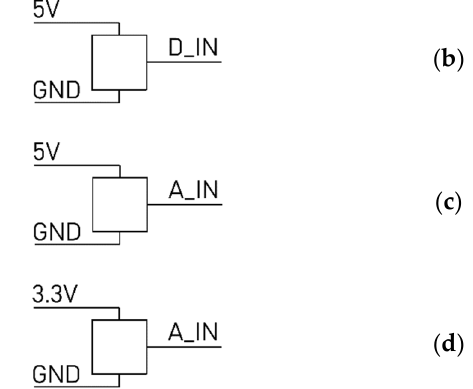
Figure 8. ECG, finger and ear heartbeat sensors’ voltages vs. time. In this second measurement, the